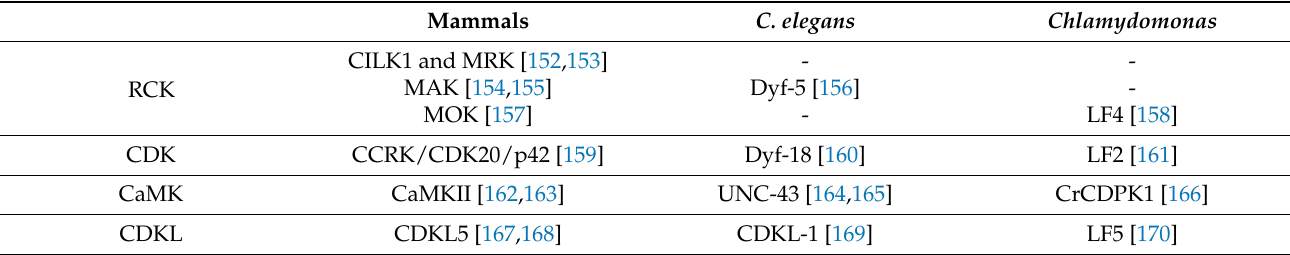
Table 1. Family names and names of kinases involved in IFT regulation.